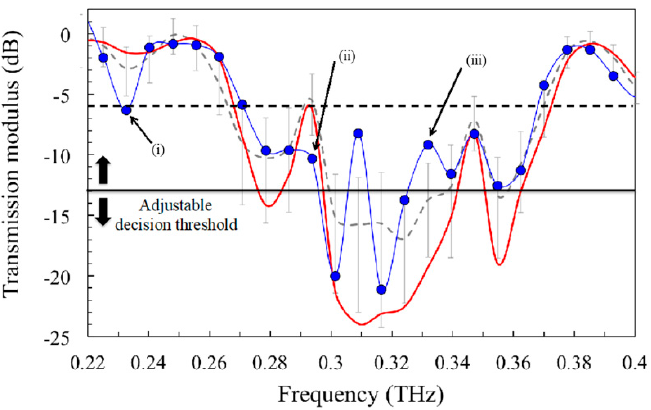
Figure 6. Example of a tag signature obtained using an acquisition time of 8 ms (blue dots and dashed curve), compared to the reference one (red continuous curve). The grey dashed curve is the transfer function obtained by averaging one hundred 8-ms measurements (error bars are given by the standard deviation). The horizontal lines represent the decision thresholds used to automat-tically define the PBG bandwidth limits (dashed line), and the peaks presence (solid